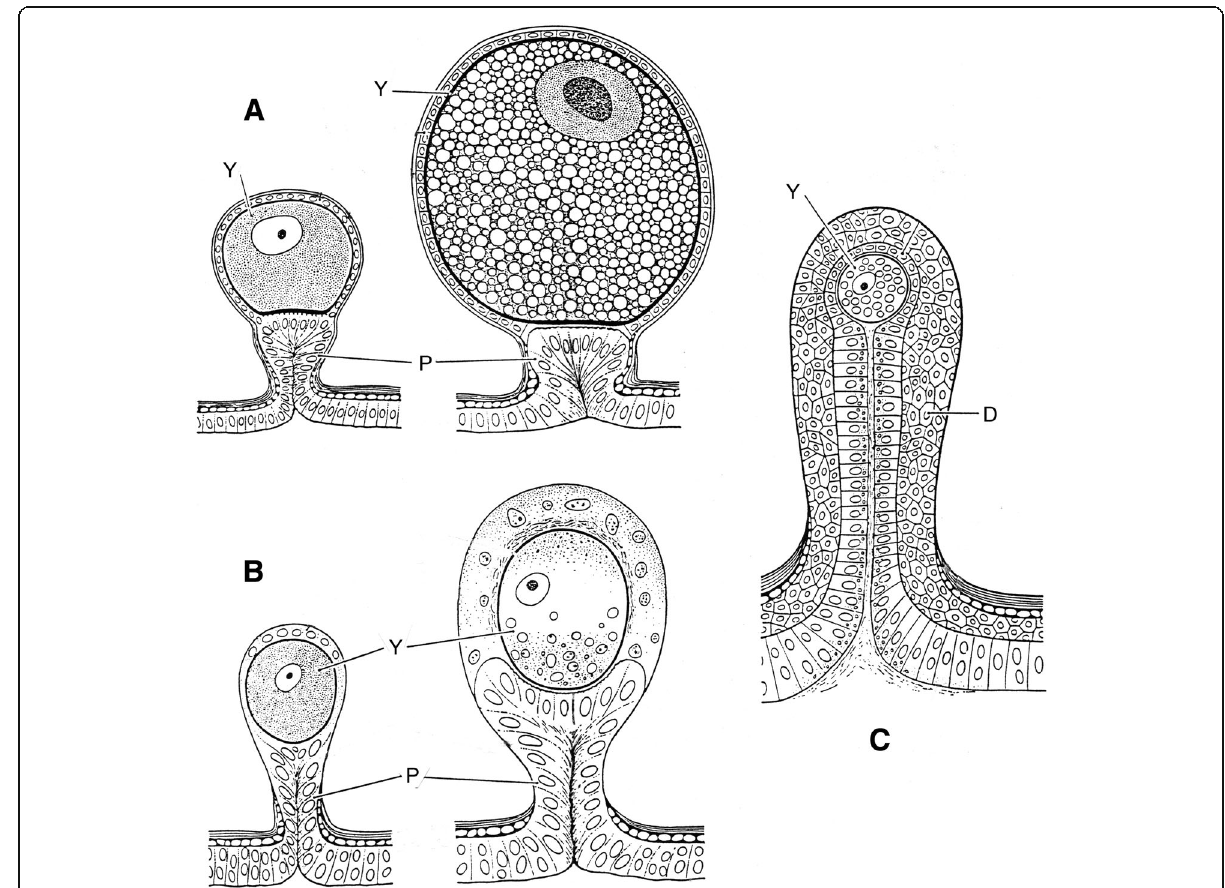
Fig. 5 Schematic embryonic development in ( a ) euscorpiid, ( b ) vaejovid and ( c ) hormurid scorpions. Yolk-producing cells of germinative epithelium (Y). P: peduncle; D: